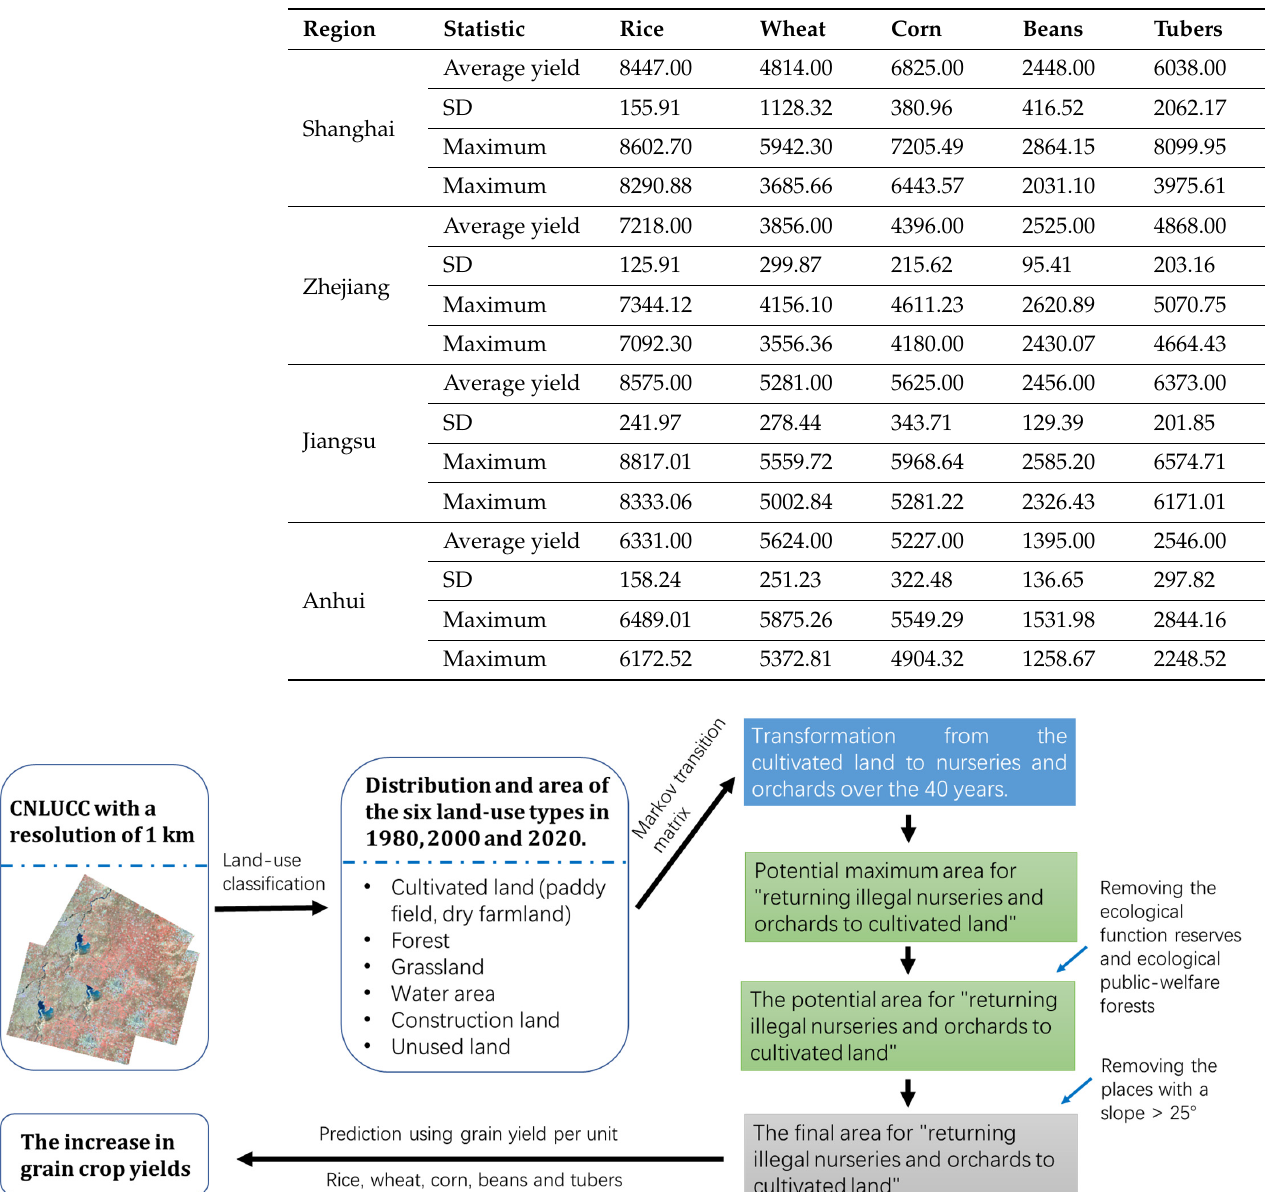
Table 2. Grain yield per unit area in the Yangtze River Delta region over the past 10 years (2010–2020) in the China Statistical Yearbook (kg/ha).